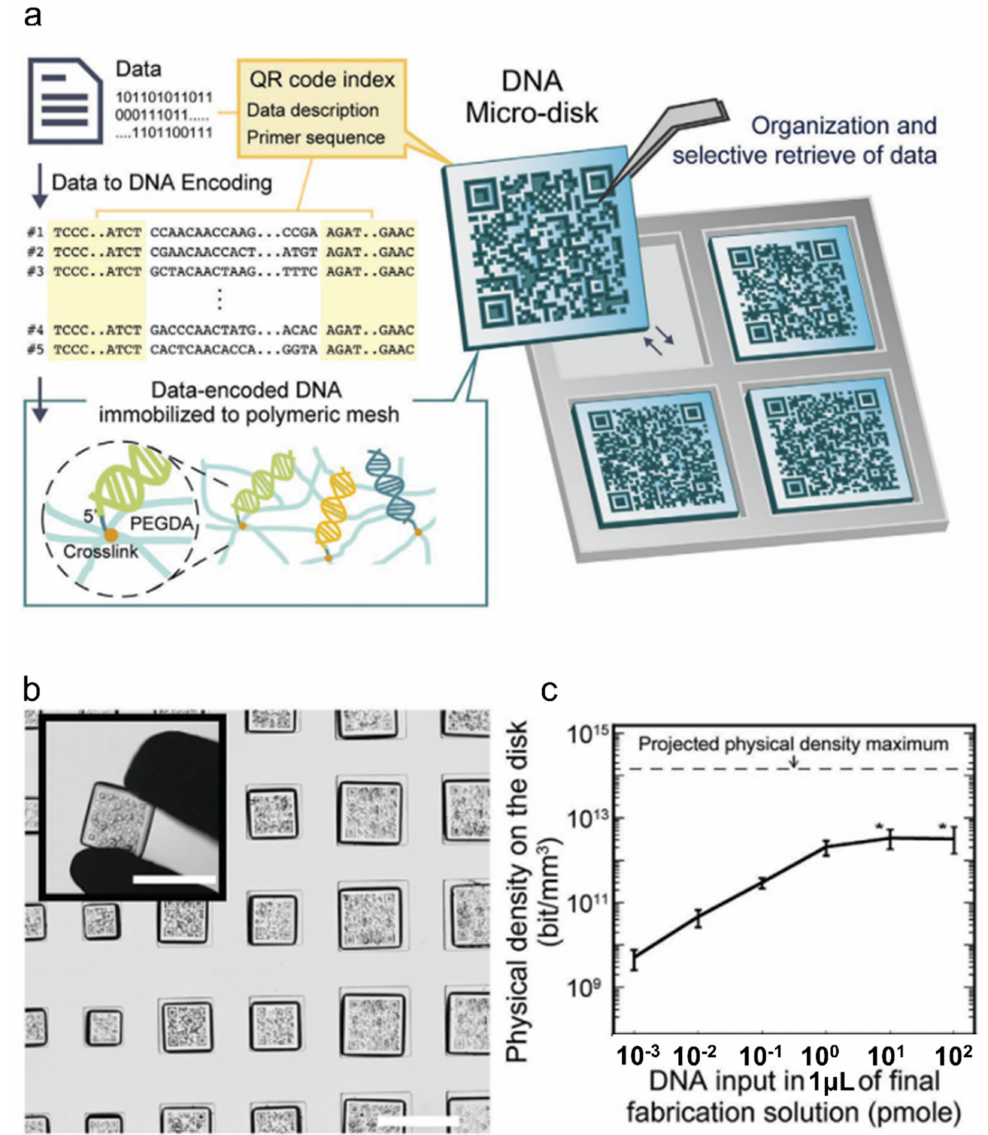
Figure 4. Hydrogel micro-disk-based DNA data storage. ( a ) Schematic of DNA template immobiliza- tion on hydrogel micro-disk with QR code for encoding information of data-encoded DNA. ( b ) Image of an array of DNA micro-disks; scale bar: 500 um. ( c ) Capability of tunable data storage capacity; adapted with permission from [58]. Copyright 2020